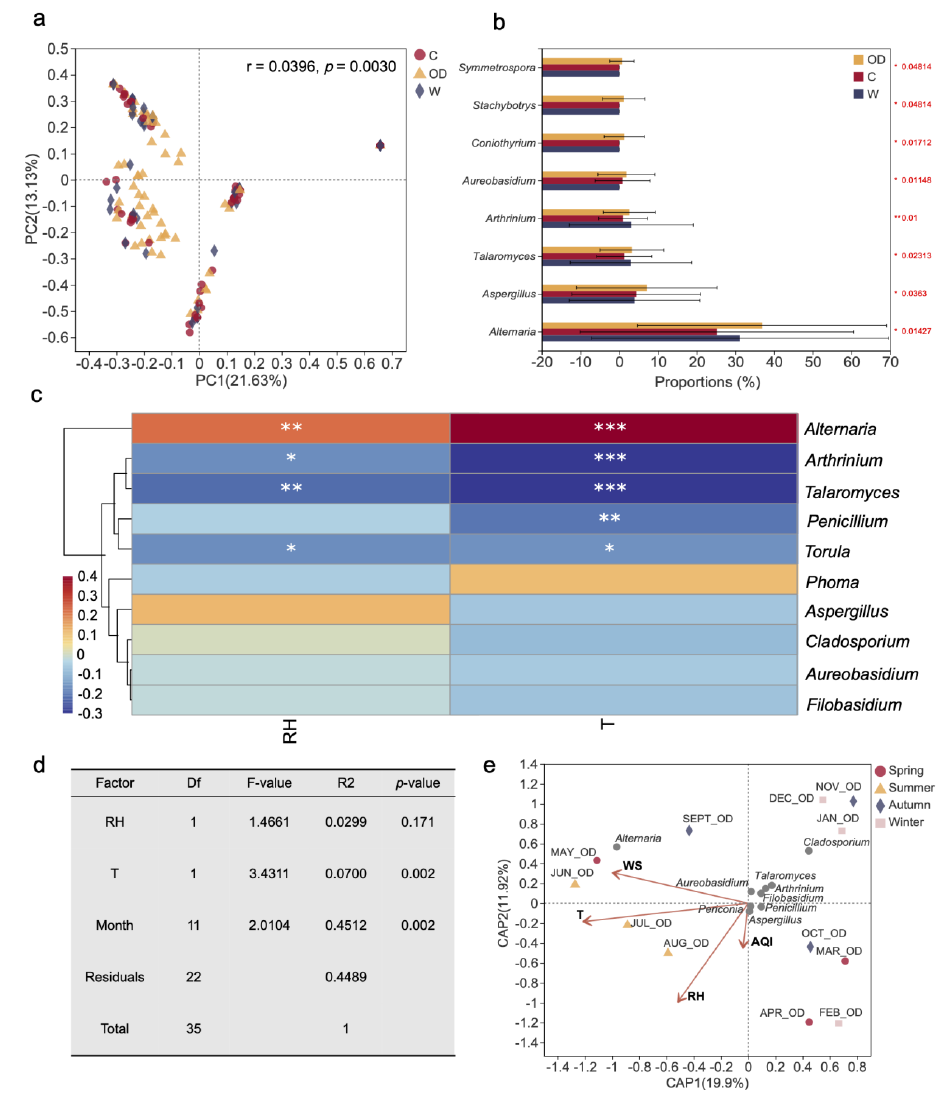
Figure 9. Variance between fungal communities in three sampling locations and effects of environ- mental factors on the airborne fungal diversity. ( a ) Principal coordinate analysis plot of fungal com- munities in the sampling building based on Bray – Curtis distance. The r and p -value of the analysis of similarity were shown in the figure ( p < 0.01). ( b ) Comparison of the significantly different genera in the three analyzed locations according to abundances. Differences in the genera as evaluated by Kruskal-Wallis test (c) Correlation heat map of the top ten genera and environmental factors. Dif- ferent co lors infer to Spearman’s rank correlation coefficients (r). ( d ) Effects of month, RH and T on whole building fungal community based on permutational multivariate analysis of variance. ( e ) Distance-based redundancy analysis of the outdoor fungal communities with symbols coded by seasons and top ten fungal genera. In the sub- figures, OD, C and W refer to “Outdoor”, “Corridor” and “Washroom”, while T, RH, WS and AQI refer to “temperature”, “relative humidity”, “wind speed” and “air quality index”, respectively . The value p is indicated as: * p < 0.05, ** p < 0.01, *** p < 0.001.